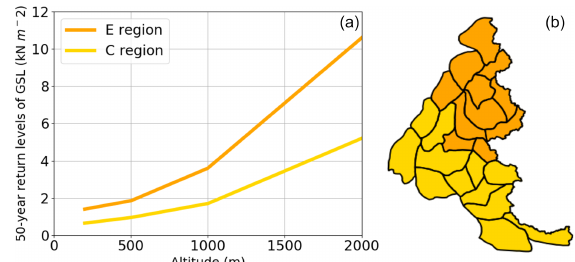
Figure 2. (a) French standards 50-year return levels of ground snow load (GSL) with respect to altitude for regions C and E. (b) Map of the region type for each